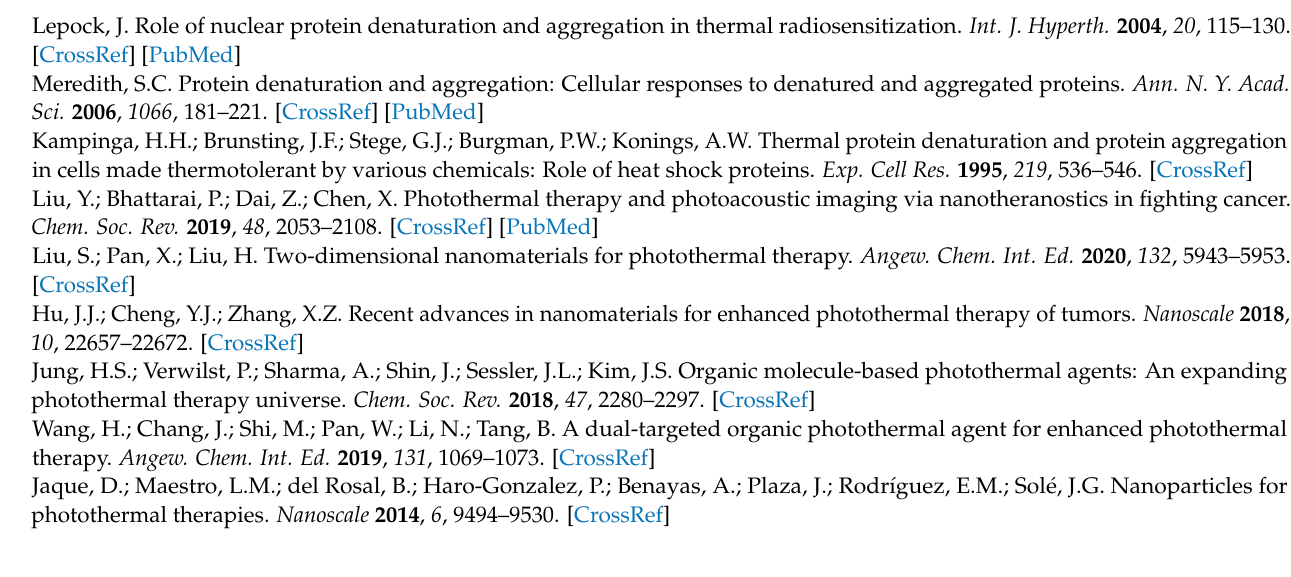
NdVO 4 nanoplates. Figure S2: NIR-II emission spectrum of as-obtained NdVO 4 :Gd 3+ -pDA solution. Figure S3: Surface charges of NdVO 4 :Gd 3+ -pDA (1) and NV-p@BSA (2) aqueous solution. Figure S4: Typical thermal gravimetric analysis curve of NdVO 4 :Gd 3+ and NdVO 4 :Gd 3+ -pDA nanoplates. Figure S5: The particle size of NV-p@BSA NPs in PBS solution over 72 h. Figure S6: Temperature increases by NV-p@BSA over three on/off cycles of 808 nm irradiation. Figure S7: The confocal microscope images of HeLa cells after being cultured with NV-p@BSA NPs for 24